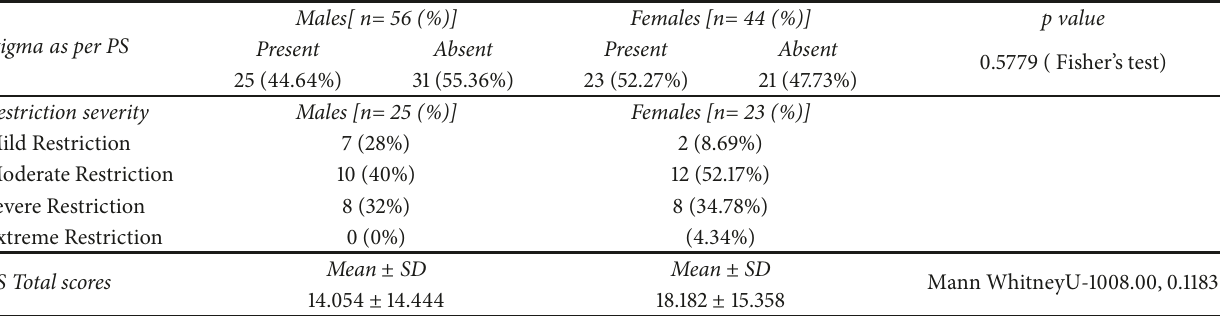
Table 3: Prevalence and severity of stigma as per participation scale.